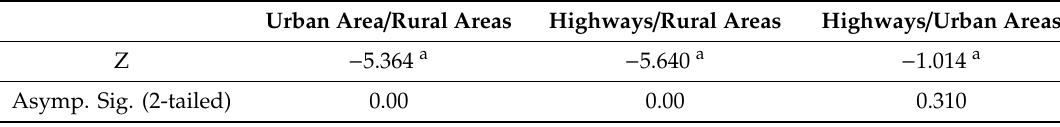
Table 9. Wilcoxon sign test (statistics) for connected vehicles.